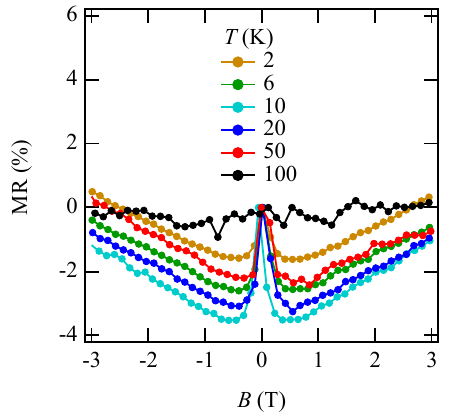
Figure A5. Enlarged view of Figure 10e in the low magnetic field region of MR as a function of magnetic field and temperature at 9.3 GPa.